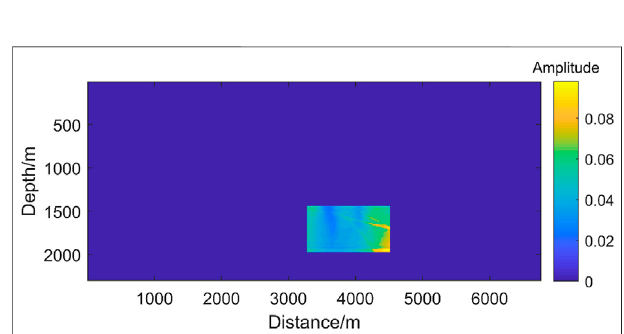
FIGURE 6 | The location of target area which is arti fi cially selected according to the illumination